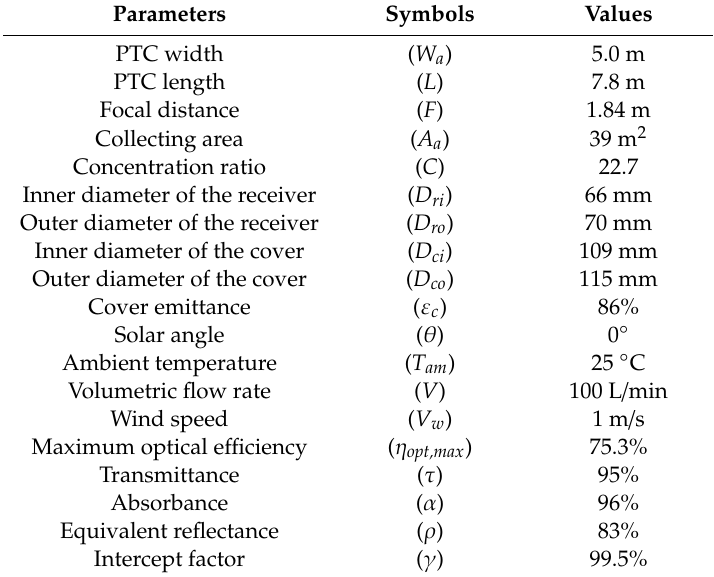
Table 1. Data of the studied parabolic trough solar collector (PTC) module [31,32].